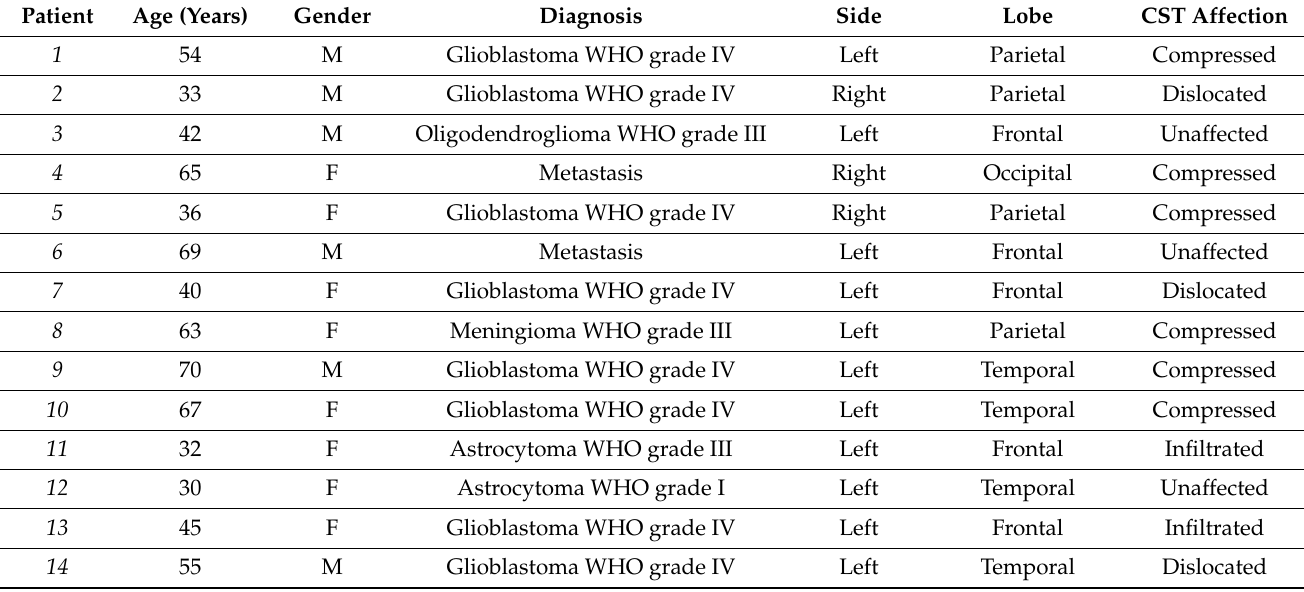
Table 1. Demographic